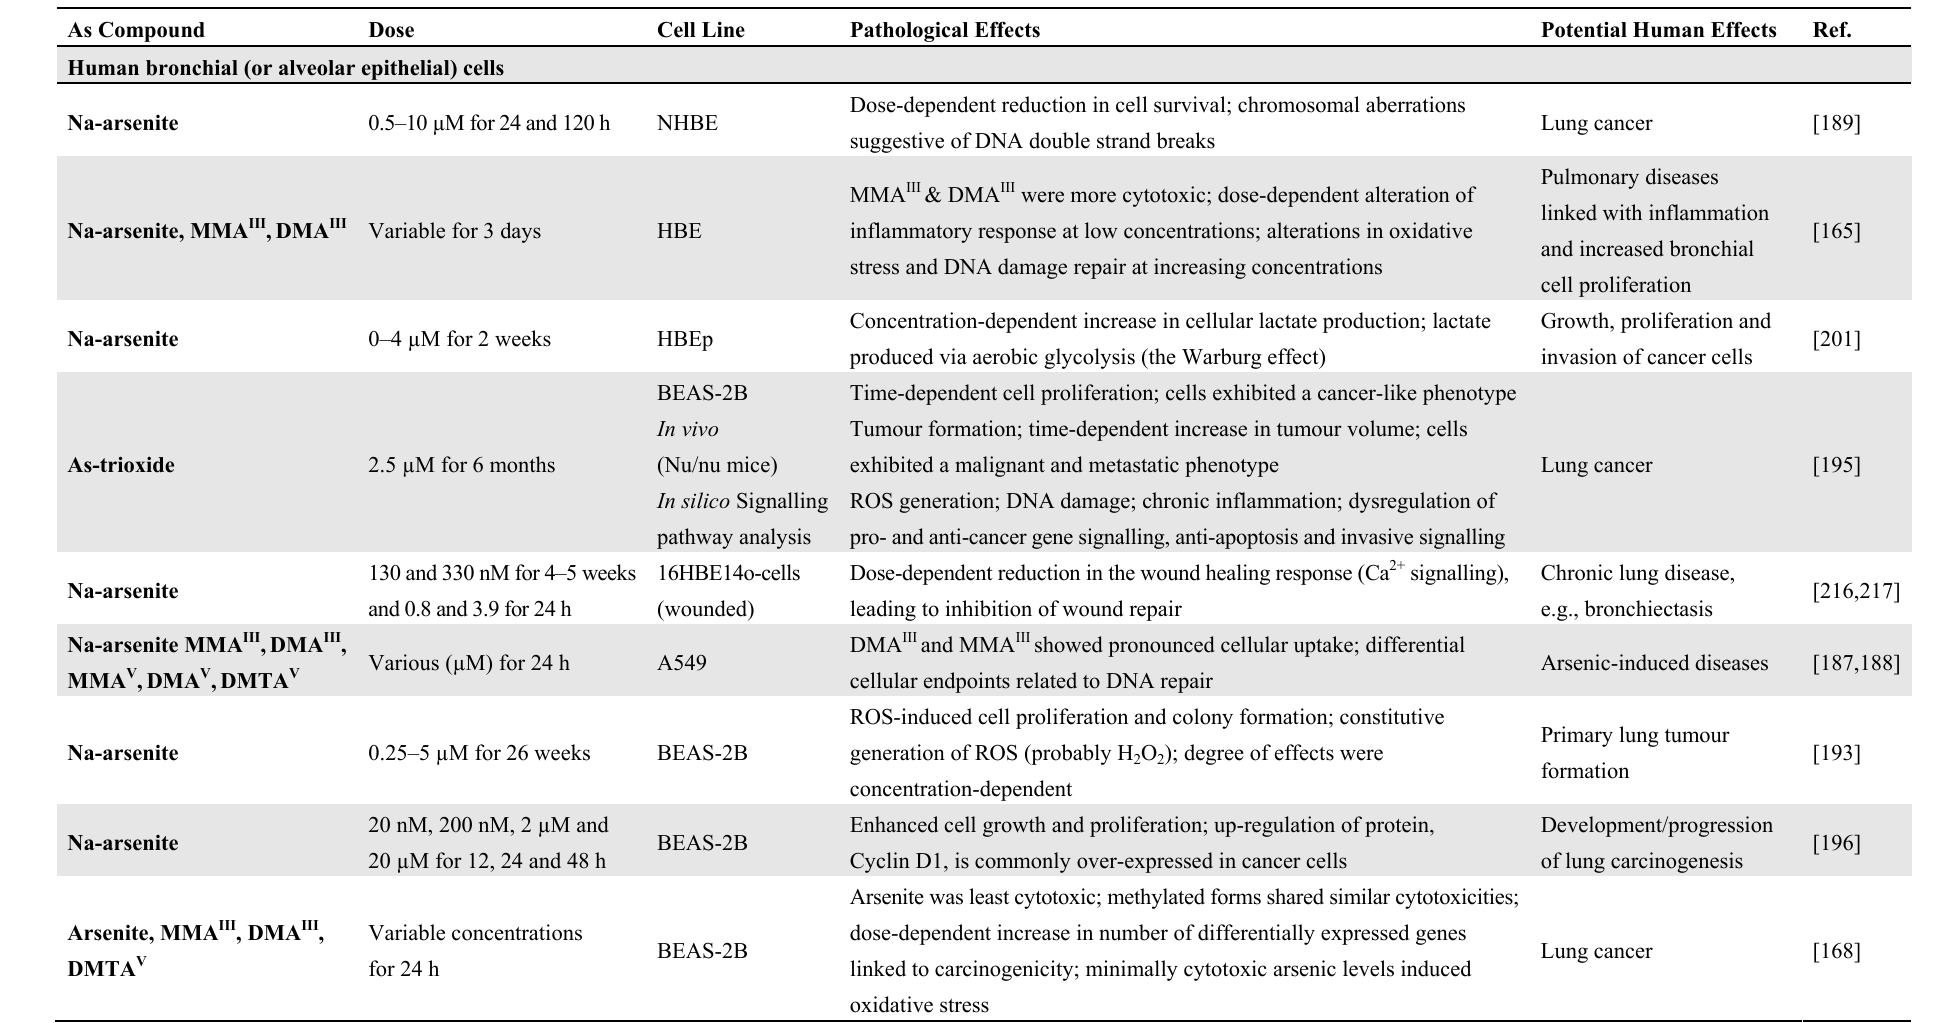
Table 3. Direct effects of arsenic exposure on human bronchial epithelial (HBE) cells, human pulmonary fibroblast (HPF) cells, and pulmonary alveolar macrophage (AM) cells. All experiments were conducted in vitro , unless otherwise specified. Specific cell lines are listed in accordance with the abbreviations used in each